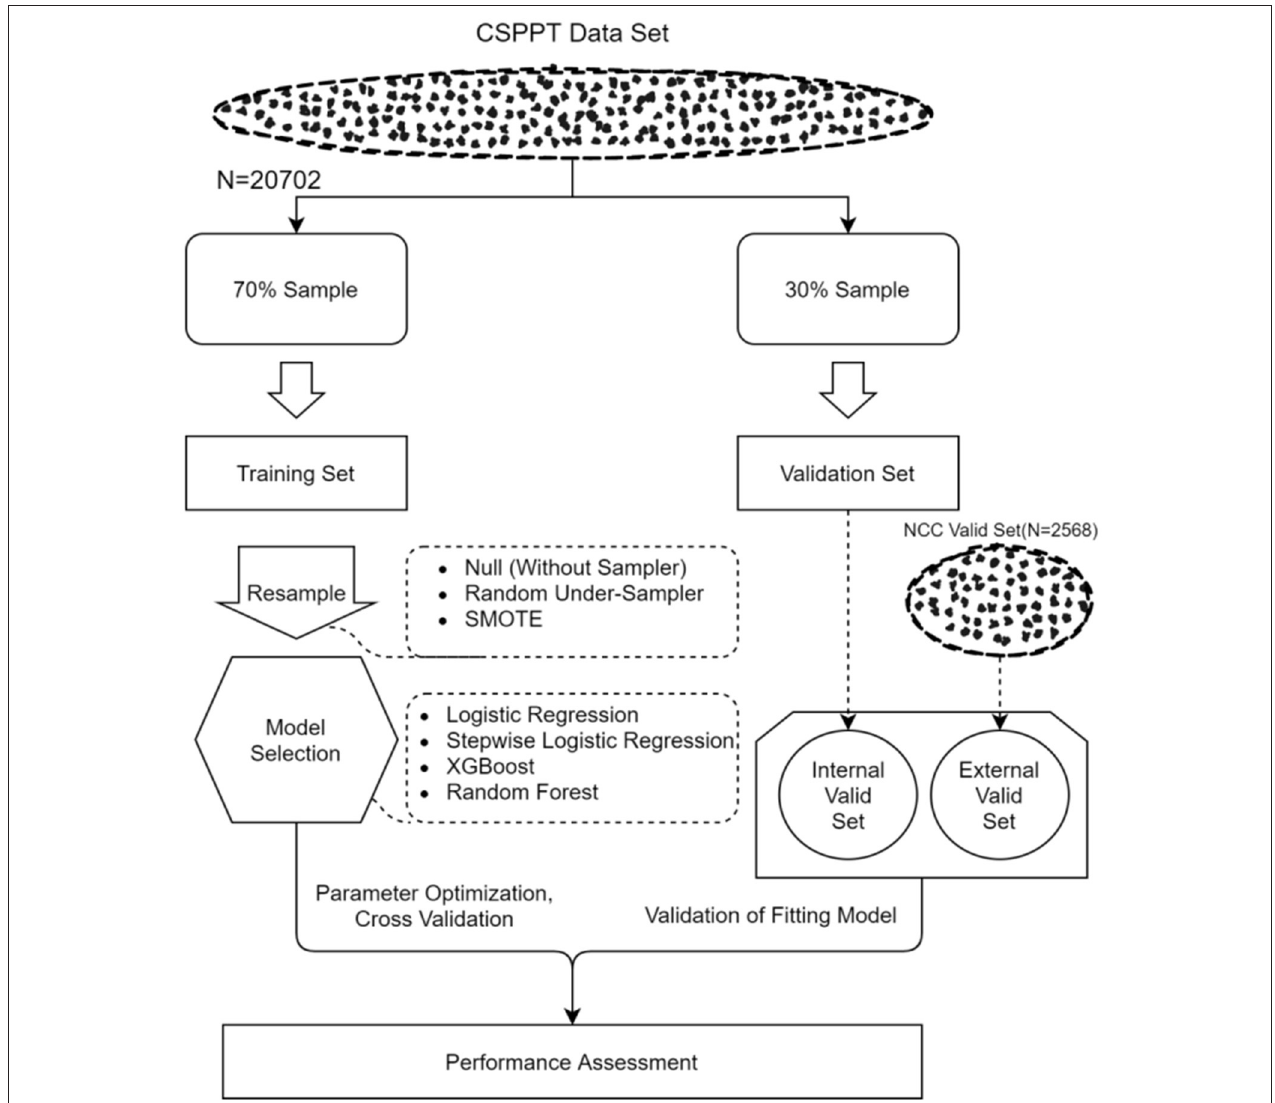
FIGURE 1 | Analysis flow for the development and evaluation of